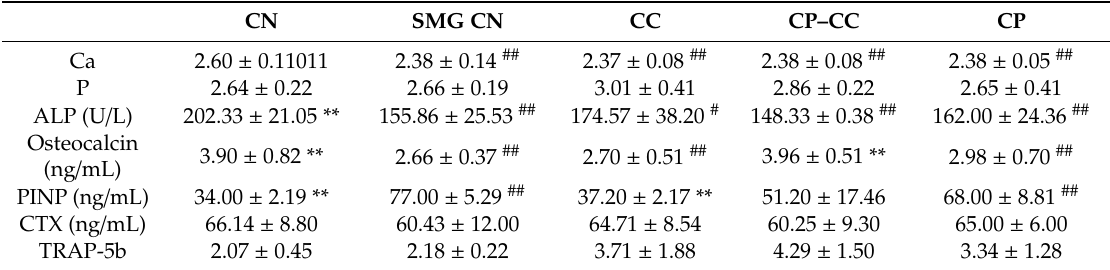
Table 2. Serum levels of bone turnover biomarkers analysis.